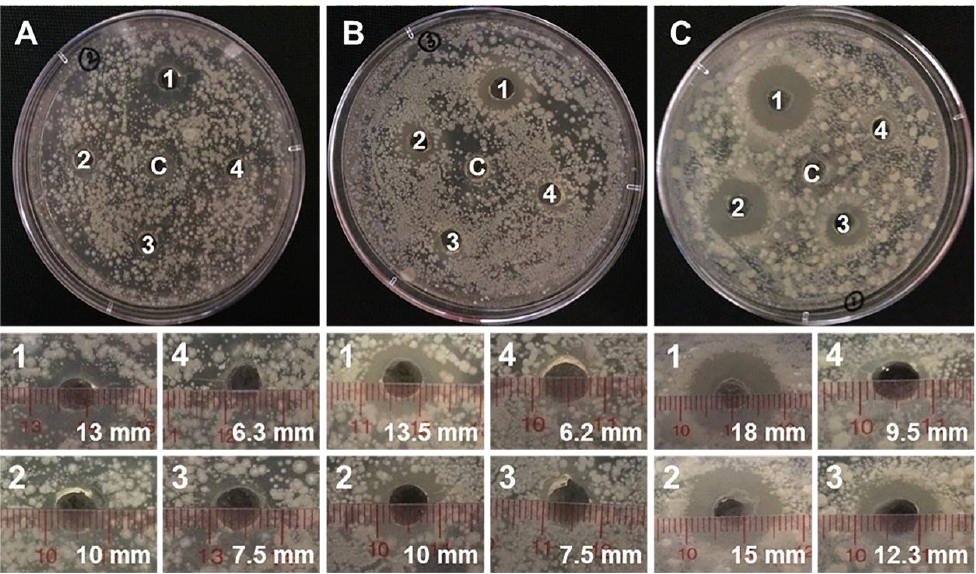
Figure 8. Diameters of inhibition zone of ( A ) Marjoram essential oil; ( B ) dendrimer PAMAM G4.0; ( C ) oil/PAMAM G4.0 after 48 h with different concentrations: (1) 5000 ppm; (2) 2000 ppm; (3) 1000 ppm: (4) 500 ppm.